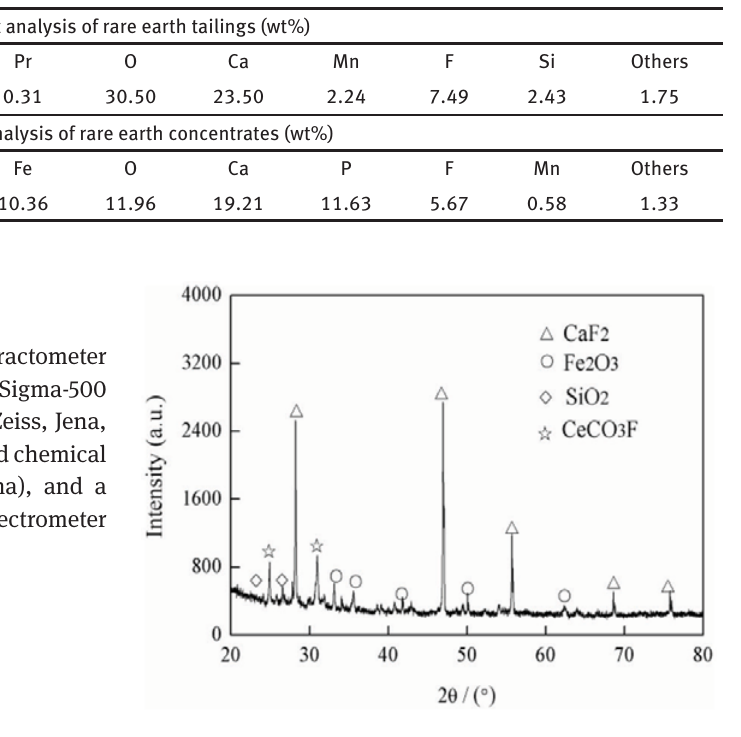
Figure 2: XRD of rare earth tailings.